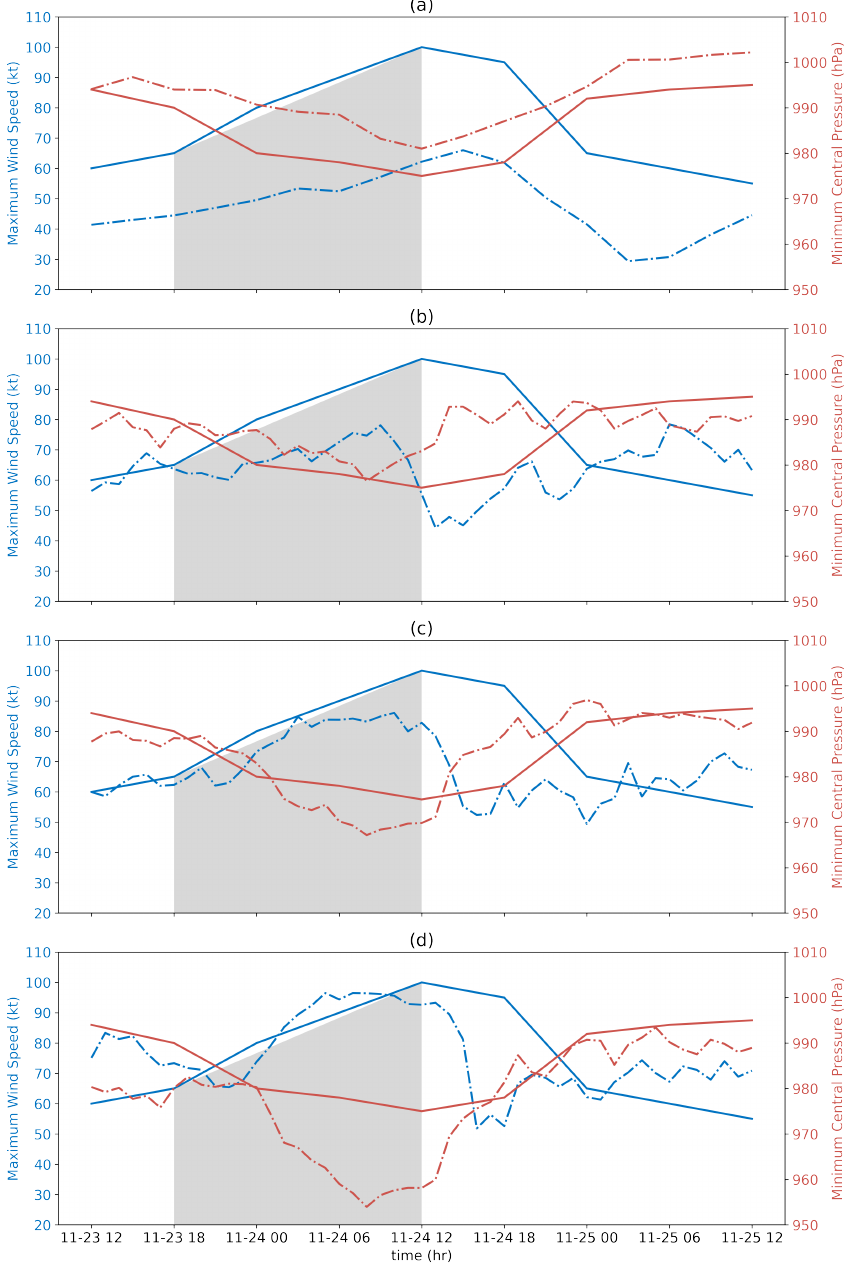
Figure 5. Comparison of Hurricane Otto evolution in terms of maximum surface wind speed (blue lines) and SLP (red lines) as detected in Best Track (solid lines, ( a ) GFS) and experiments (dashed lines, ( b ) CRUN_MRF, ( c ) EX01_MYJ, ( d ) EX02_YSU). Shaded area shows the rapid intensification (RI) period in Best Track